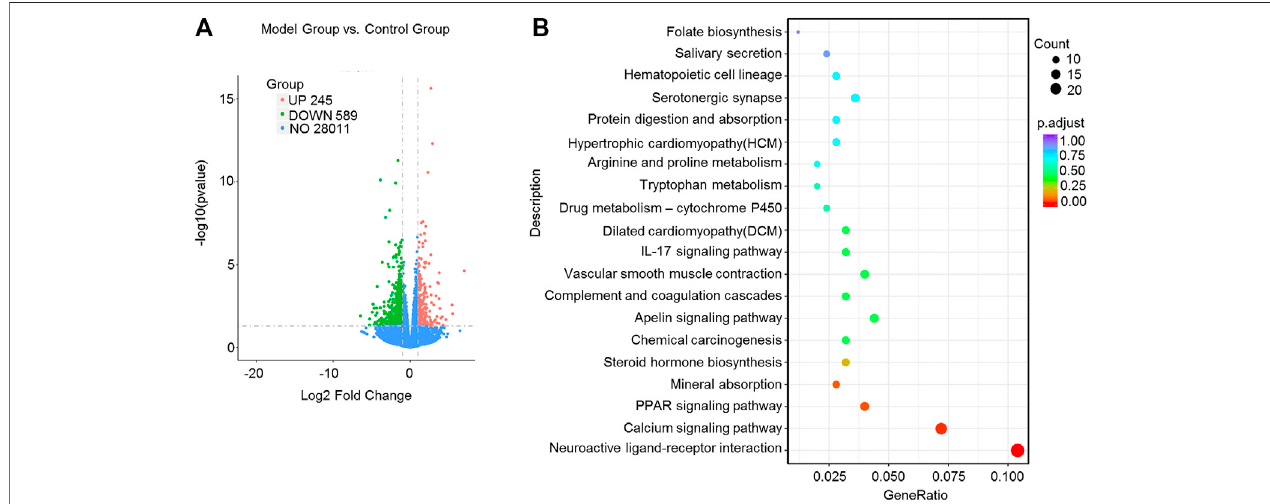
FIGURE5| High-throughputtranscriptomesequencingandKEGGpathwayenrichmentanalysis.Naringin(40 mg/kg)wasadministeredtomicebygavageoncea day for seven consecutive days and total RNA was extracted from colonic epithelial cells. (A) Volcano plot of differentially expressed mRNAs in model group vs. control group. (B) The scatter plots showing the top 20 enriched KEGG pathways in model group vs. control group. The Rich factor is the ratio of differentially expressed gene numbersannotatedinthispathwaytermtoallgenenumberannotatedinthispathwayterm.Greaterrichfactormeansgreaterintensiveness.Q-valueiscorrected p value ranging from 0 to 1.